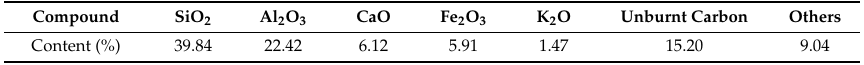
Table 1. The major chemical compounds of coal fly ash from gasification (wt %, dry